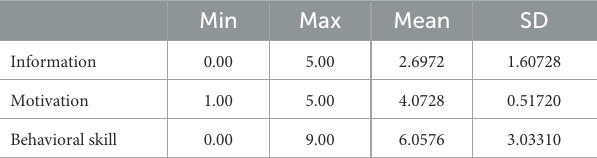
TABLE 6 Average scores of 3 dimensions in 22-item